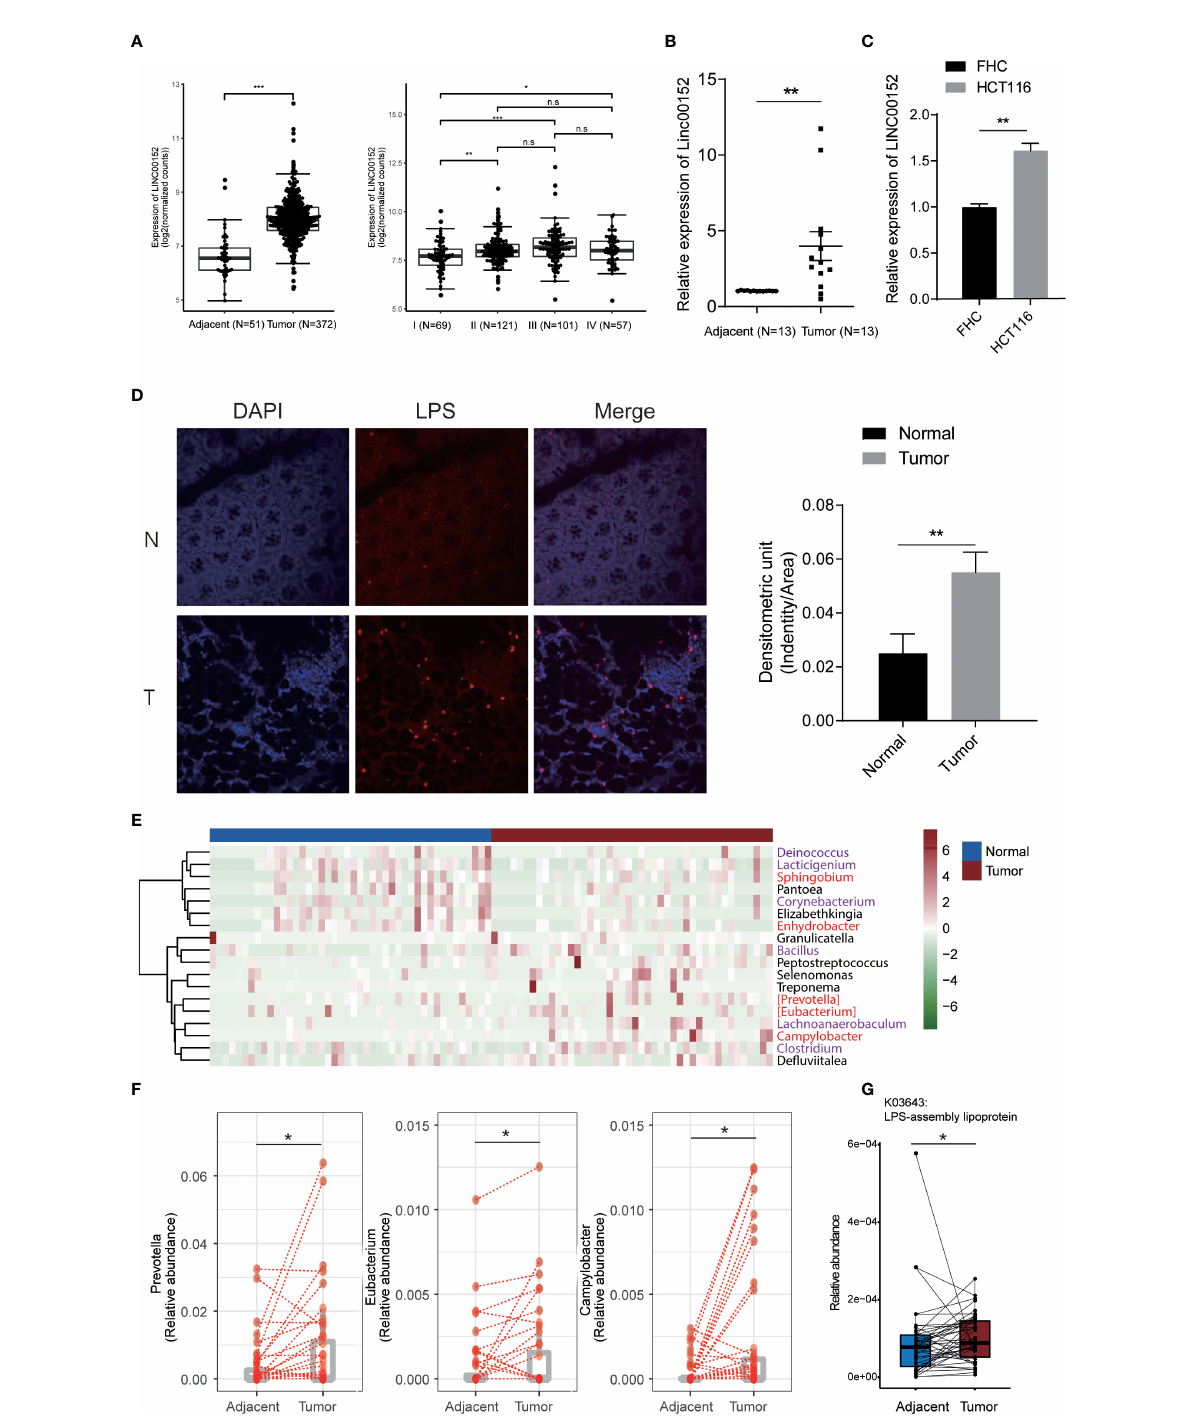
FIGURE 3 lncRNA expression and bacteria abundance of CRC samples. (A-C) The expression of LINC00152 in TCGA colorectal samples (A) , our clinical CRC samples (B) , and the HCT116 cell (C) . (D) The level of LPS in tumor tissue and the adjacent normal mucosa. Experiment was performed in three replicates. (E) The differential species between tumor tissues (N=44) and the adjacent normal ones (N=44). Red and purple labeled species are gram-positive and negative bacteria, respectively. (F) The expression of gram-negative bacteria in tissue and normal samples. (G) The increased LPS-assembly lipoprotein in tumor tissue compared with normal tissue adjacent to the tumor. * P < 0.05; ** P < 0.01; *** P < 0.001; n.s: not signi fi